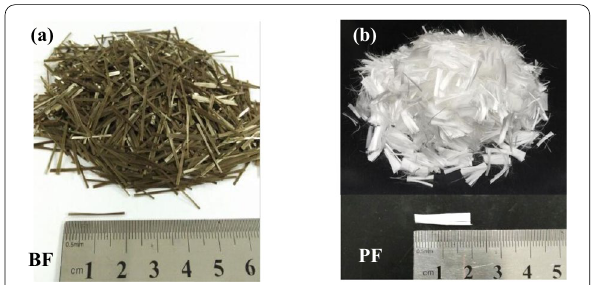
Fig. 1 Morphologies of a BF and b